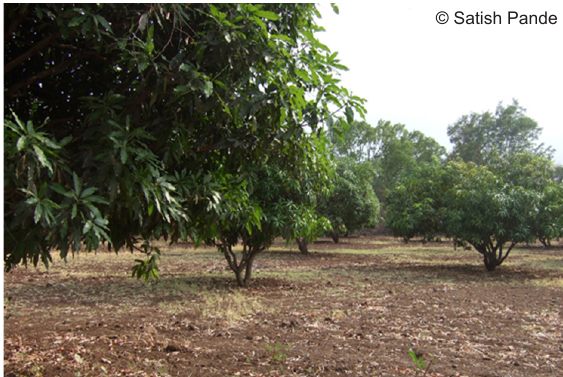
Image 5. Black soil in mango